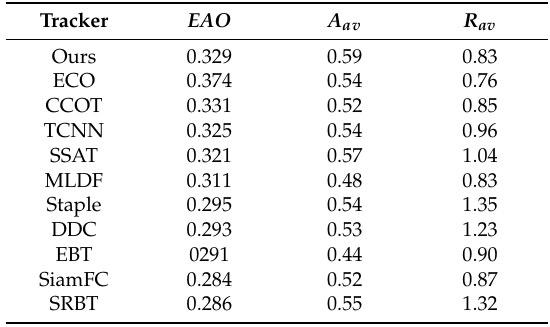
Table 2. The outperforming trackers on the VOT2016 benchmark.